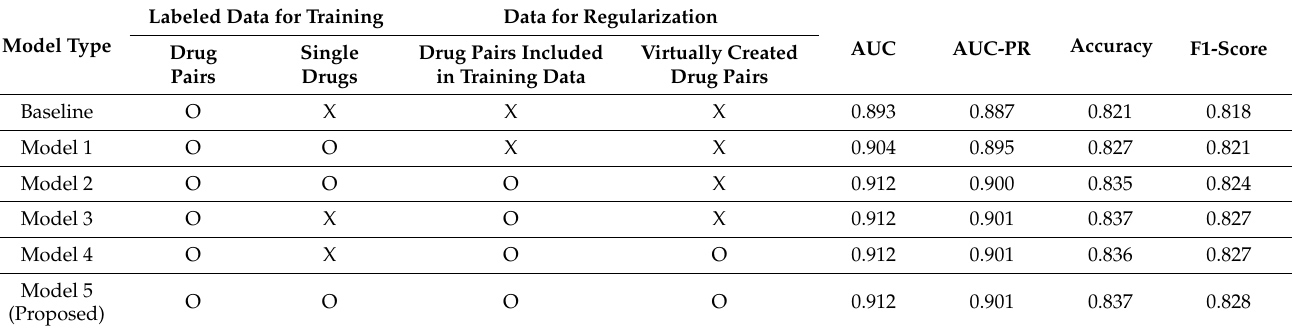
Table 3. Non-DPU side effects prediction performance for the 200 targeted side effects with respect to model characteristics: Here AUC and AUC-PR are presented as average values for 200 side effects. The hyperparameter A was set to 0.1 at which our model showed highest performance in predicting non-DPU side effects.